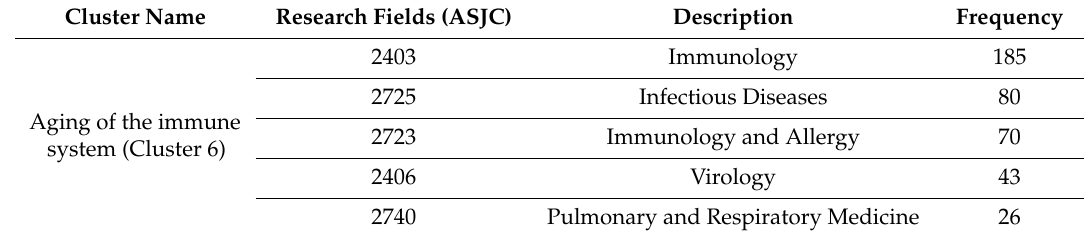
Table 7. Major research fields in Aging of the immune system (Cluster 6).